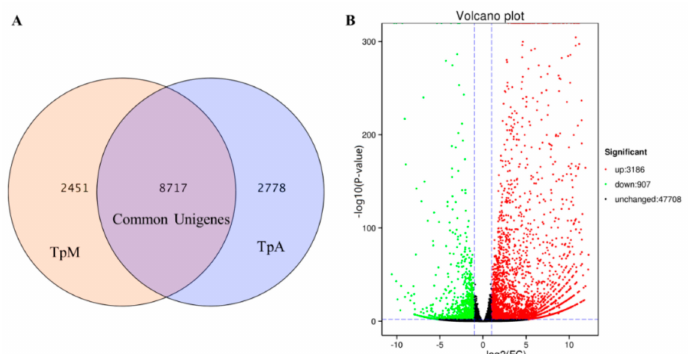
Figure 2. Distribution of expressed unigenes in the larval and adult stages of T. pisiformis : ( A ) The commonly or specifically expressed unigenes and ( B ) volcano plots of di ff erentially expressed genes (DEGs) in TpA versus TpM. Unigenes with | log 2 FC | > 1 and adjusted p -value di ff erentially expressed. Black splashes indicate genes with no significant change, and red and green splashes represent significantly upregulated and downregulated genes, respectively.